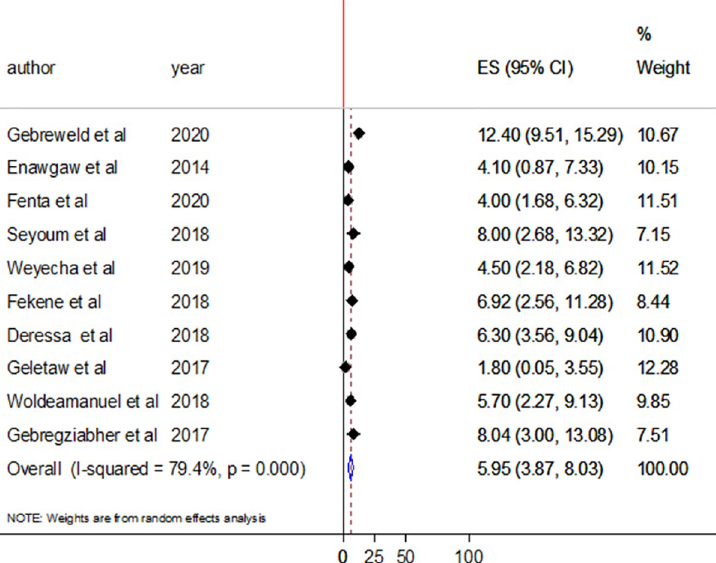
Fig 4. Forest plot showing the pooled prevalence of thrombocytopenia among HIV/AIDS patients on HAART.